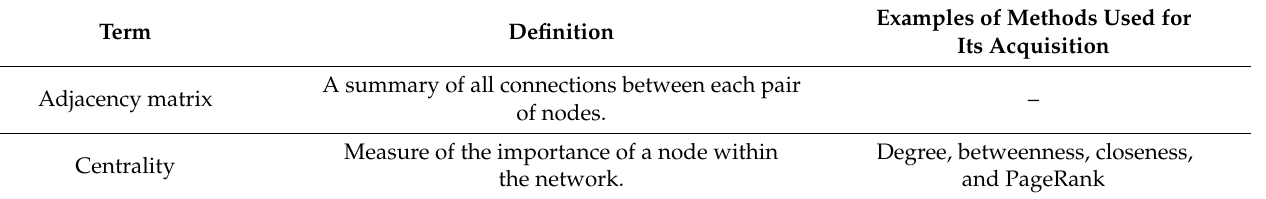
Table 1. Glossary of network